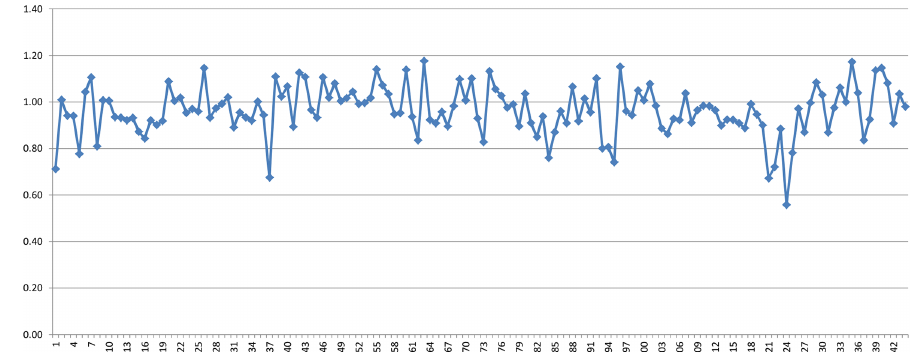
Figure 2. Plot of factors relating calculated to observed amount of H 2 O in zeolite-type minerals. The sequence from left to right follows the sequence of entries in Table 1. Entries 145 to 149 are omitted (see text for explanation). Table 2. Electronic polarizabilities α of cations from Table 4 in Shannon and Fischer (2016) averaged over different coordination numbers, including NH 4 and five H x O y